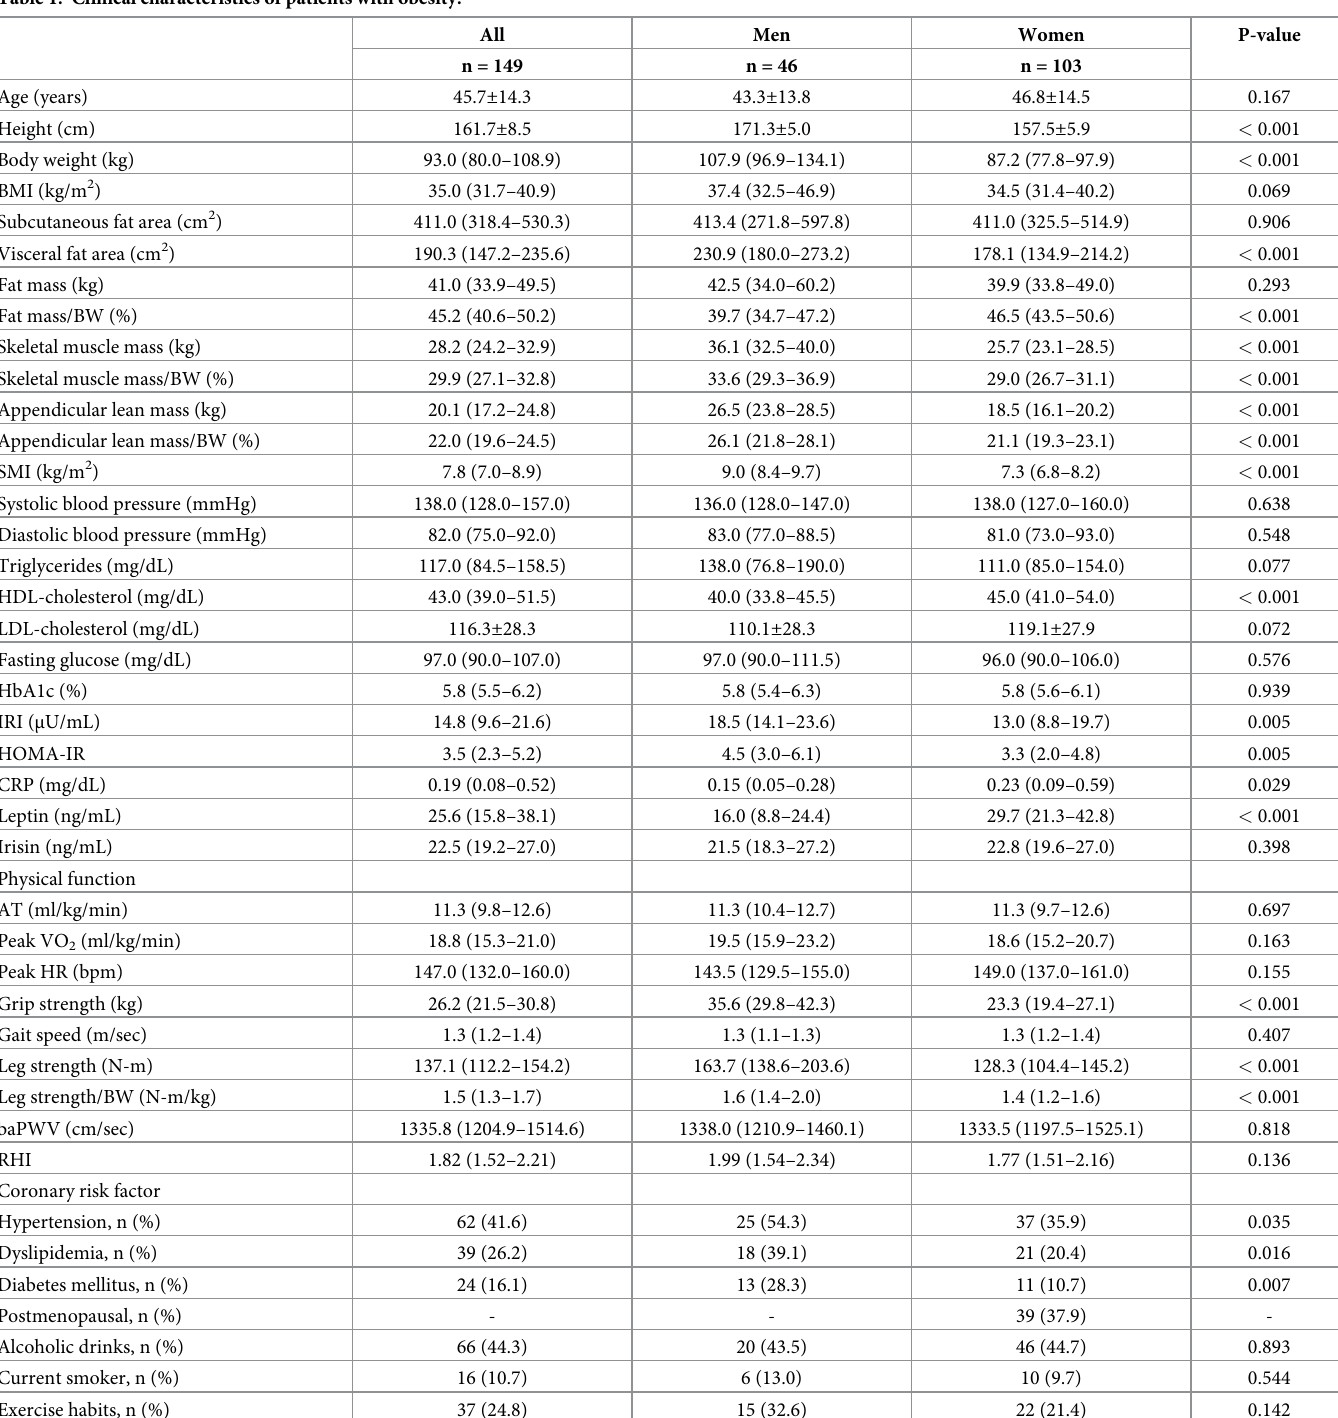
Table 1. Clinical characteristics of patients with